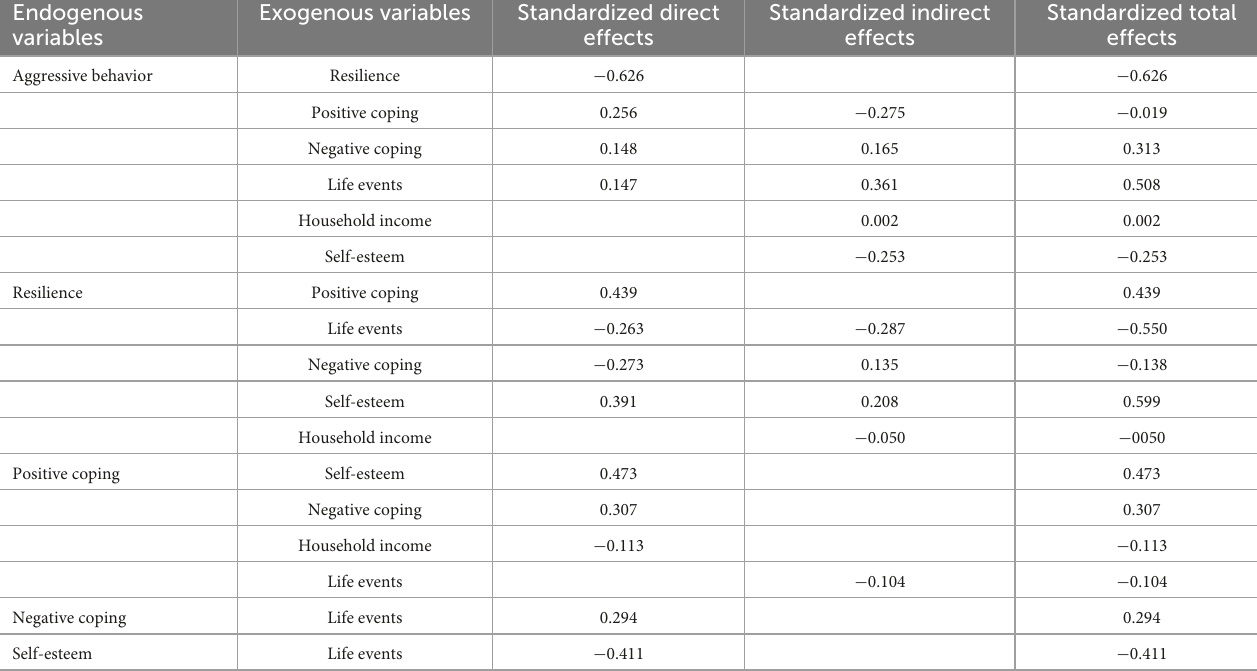
TABLE 5 Standardized direct, indirect, and total effects for the modified model.